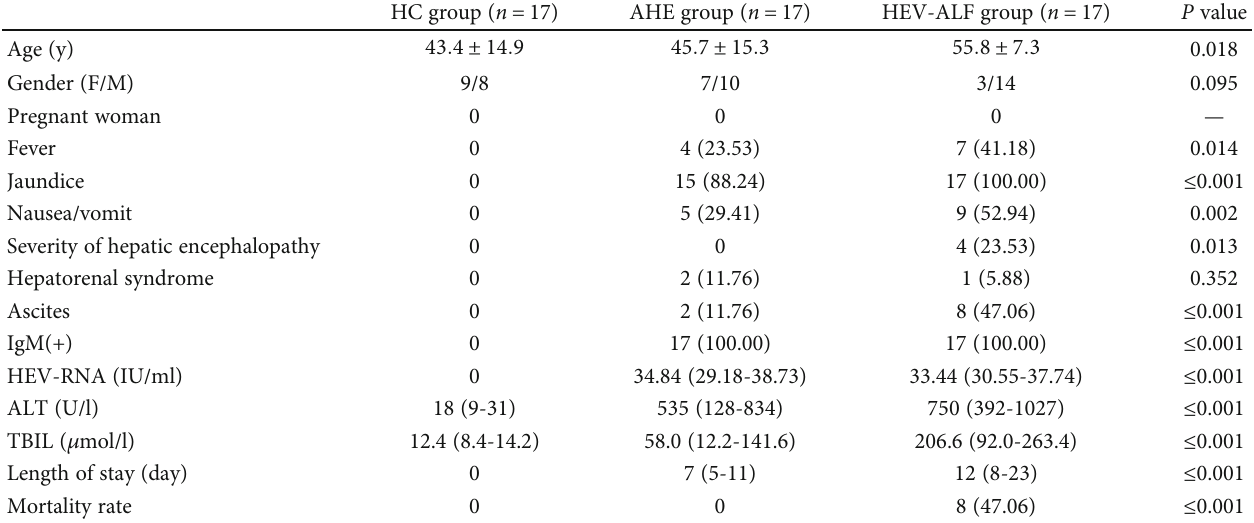
Table 1: Characteristics of study